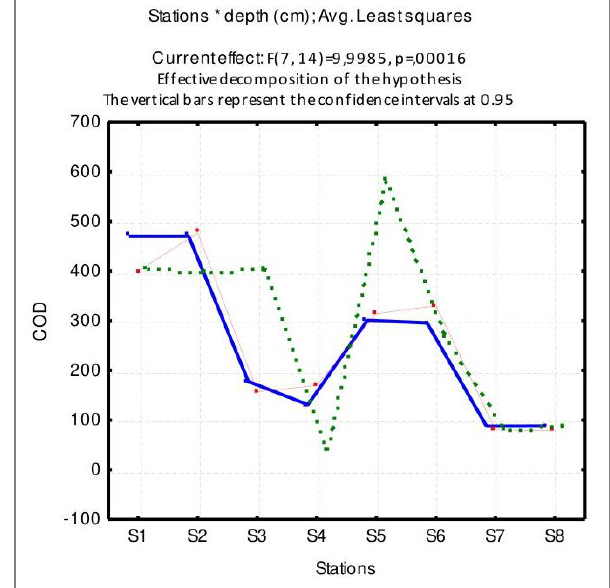
Figure 5. Spatial variation of COD in mg/l in Réghaia